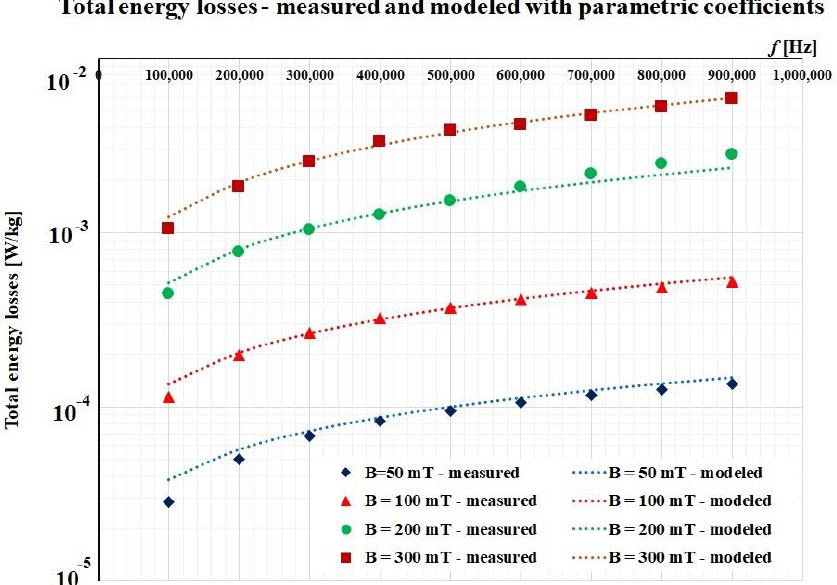
Figure 8. Fitting procedure for the FINEMET ribbon using parametric coefficients. By using such linear approximations, we were able to perform an estimation of the total magnetic losses that occur at higher values of the magnetic flux densities. Figure 9 represents the first four curves (measured and modelled) and a family of three other curves for 500 mT, 800 mT, and 1 T, respectively.